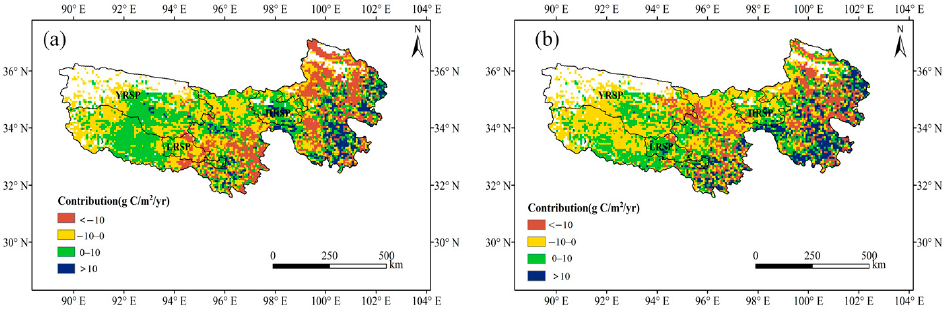
Figure 13. The contributions of other factors to the GPP ( a ) and NEP ( b ) trends in the TRSR.